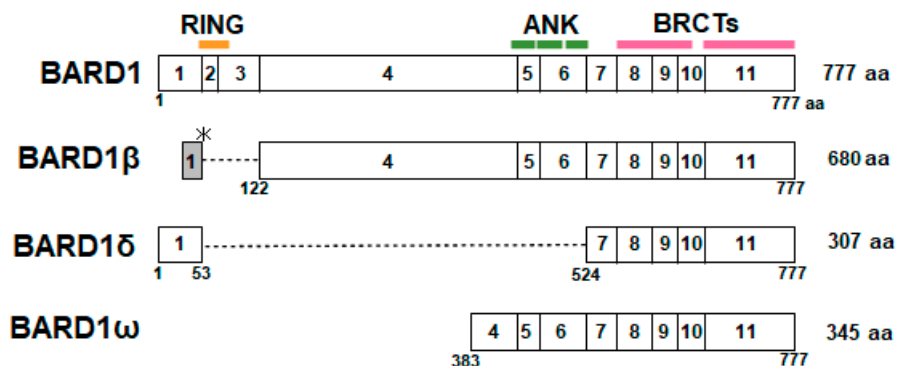
Figure 4. Structure of full-length (FL)-BARD1 and spliced isoforms of BARD1. BARD1 β is translated from an alternative open reading frame (ORF) in exon 1, and exons 2 and 3 are deleted, resulting in the lack of the RING domain. In BARD1 δ , exons 2–6 are deleted, and it lacks the RING domain and ANK repeats. BARD1 ω consists of C-terminal region of exon 4 and exons 5–11, which encode the ANK repeats and BRCT domains.